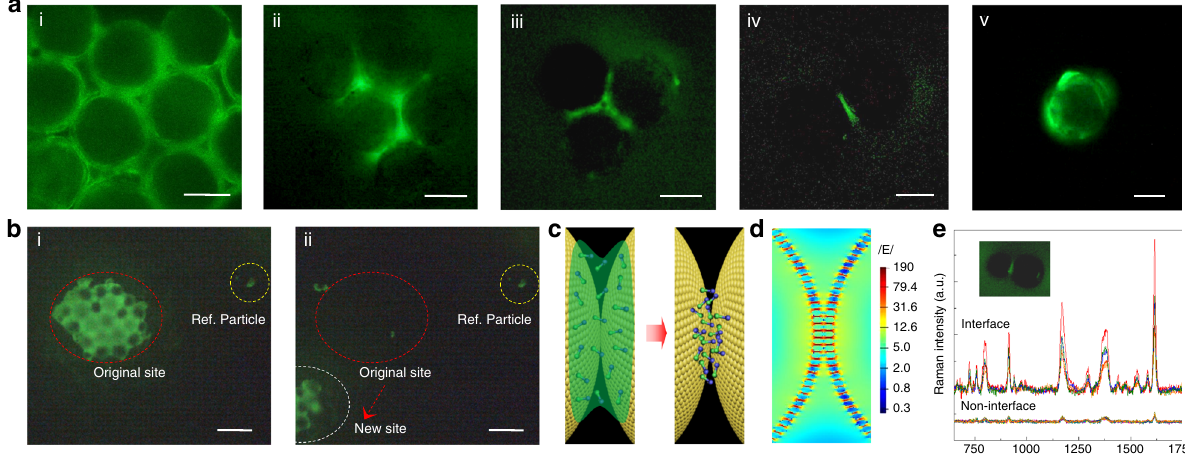
Fig. 2 Enriching effect, lifting effect, and fl uorescent characterizations. a Fluorescent images of fl oating particle aggregate with various CV concentrations. A strong fl uorescent signal can be observed clearly in the vicinity of particle – particle interface. b Fluorescent images with CV concentration of 10 − 8 M. The red circle showing that after we moved the aggregate, the original site on the substrate does not display any fl uorescent signal. c The schematic illustrations of the solvent ring fi nally adsorbs on the particle – particle interface using the present buoyant particulate protocol. d FDTD simulation of the plasmonic coupling sites of dimer buoyant particulates. e Raman spectra collected from the interface and non-interface regions for a dimer fl oating particles with CV concentration of 10 − 9 M. The insets are the fl uorescent images of a dimer buoyant particulate, demonstrating a 10 – 20 times of signal difference between interface and non-interface regions. The scale bar in ( a ) is 20 μ m and in ( b ) is 100 μ